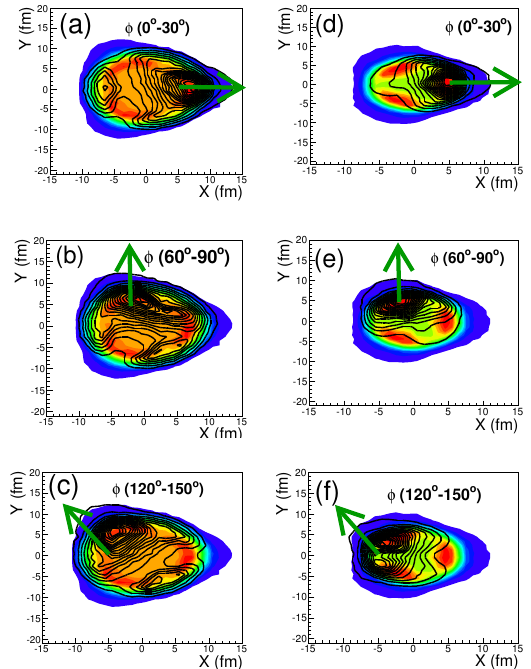
Figure 6. The same as Figure 5, but for calculations with non-zero geometric triangular anisotropy ε 3 = 0.3 ( left column ) and with non-zero dynamical triangular anisotropy ρ 3 = 0.5 ( right column ). Contour lines show the densities of pions emitted at angles 0 < φ ≤ π /6 ( upper row ), π /3 < φ ≤ π /2 ( middle row ), and 2 π /3 < φ ≤ 5 π /6 ( bottom row ),